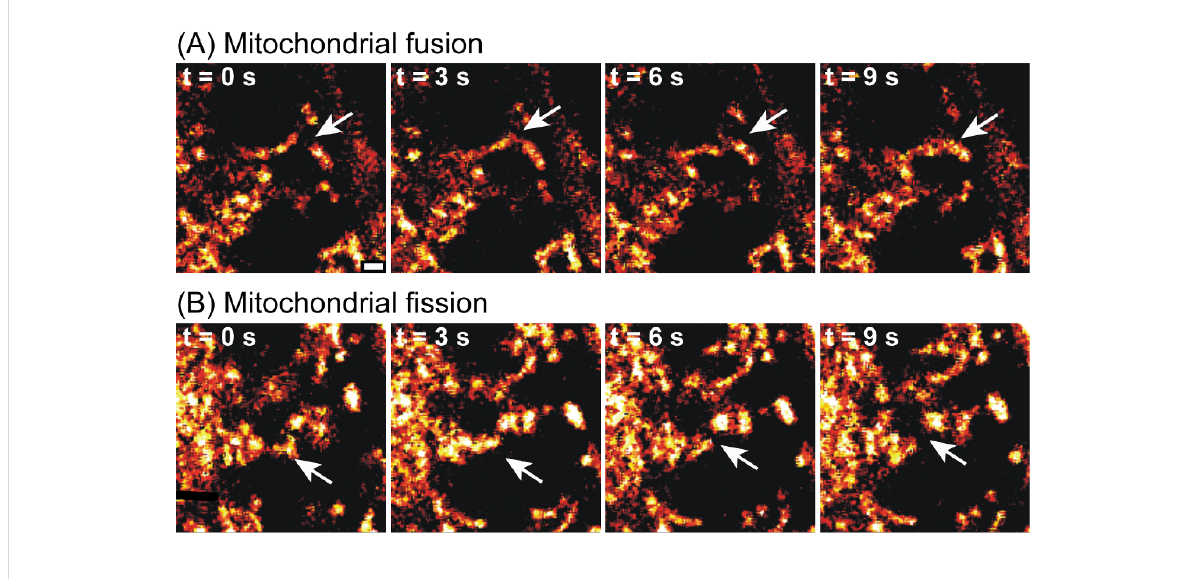
Figure 6: Images of mitochondrial motility, fusion, and fission in the germline of C. elegans extracted from confocal video microscopy. White arrows indicate fusion and fission of specific mitochondria. Prior to imaging, animals were treated with HRB ( 9 , 1 nM, 2 h). Scale bar = 1 micron.